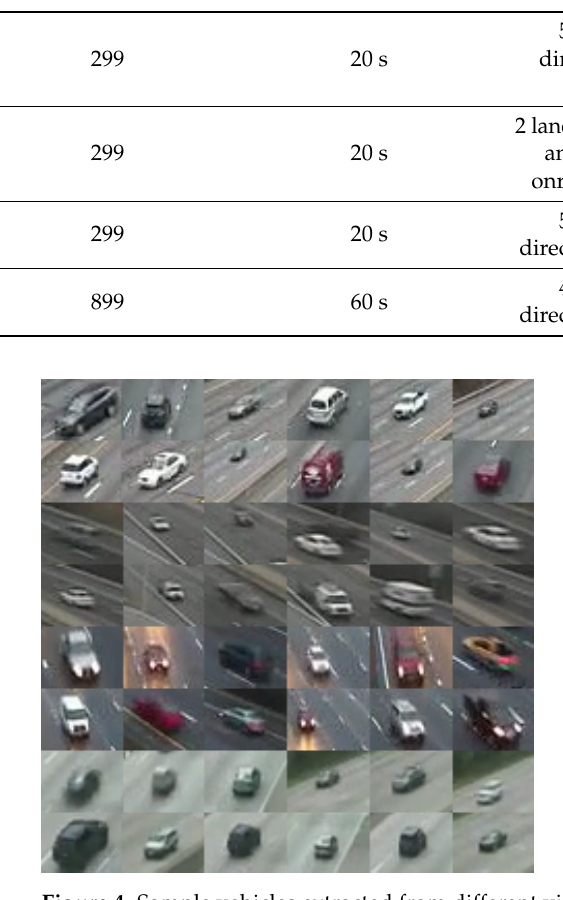
Figure 4. Sample vehicles extracted from different videos in the